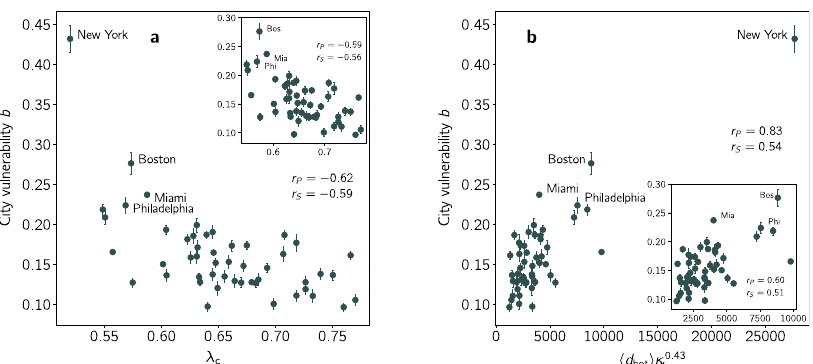
Fig. 3 Validation of the model in the United States. a Epidemic growth rate b as a function of the epidemic threshold λ c computed according to Eq. (17). In the inset, we show the same plot after removing NYC. b Epidemic growth rate b (estimated from fi tting to empirical infection data, see Methods) as a function of the average population density within hotspots 〈 d hot 〉 , measured in inhabitants per square mile, and the hotspot concentration κ . The exponent 0.43 is introduced to re fl ect the dependence obtained when fi tting the normalized epidemic threshold to κ for the United States (Table S2). In both panels, r P and r S denote the Pearson and Spearman rank correlation coef fi cients among the represented quantities. Error bars correspond to the 95% con fi dence interval.